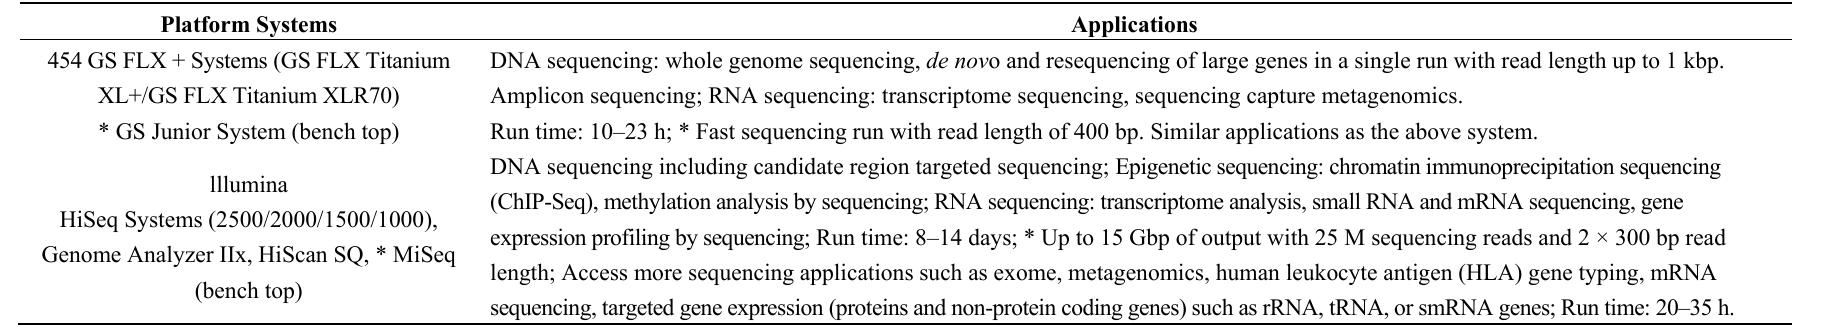
Table 2. Current models of major sequencing platform systems and their applications in next-generation sequencing